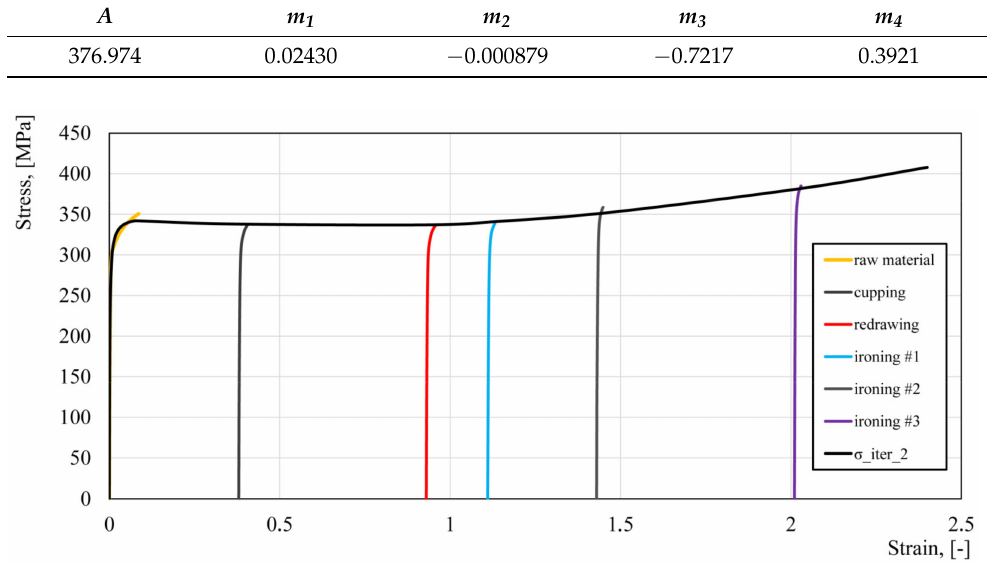
Figure 10. Approximation of the plastometric data—second